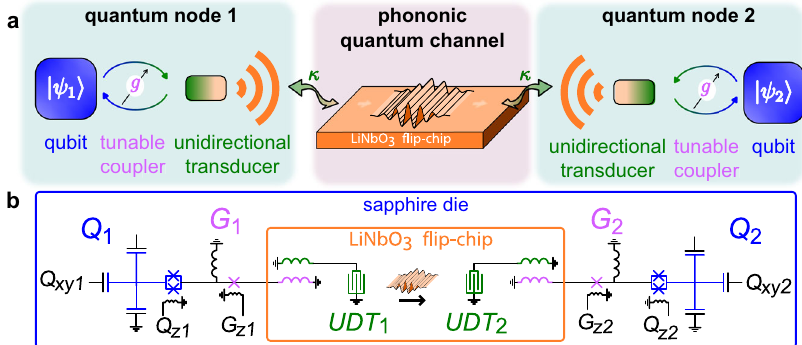
Fig. 1 Quantum delay line. a Schematic representation of the two quantum communication nodes and the phononic quantum channel. Each node comprises a superconducting qubit, a tunable coupler that allows shaping phonon release and capture, and a unidirectional phonon transducer. Details in the Methods section. b Circuit diagram of the assembled device. Each qubit Q j is excited through its dedicated Q xyj microwave line and frequency-controlled through a separate Q zj fl ux-bias line, and each tunable coupler G k is controlled via its associated G zk fl ux-bias